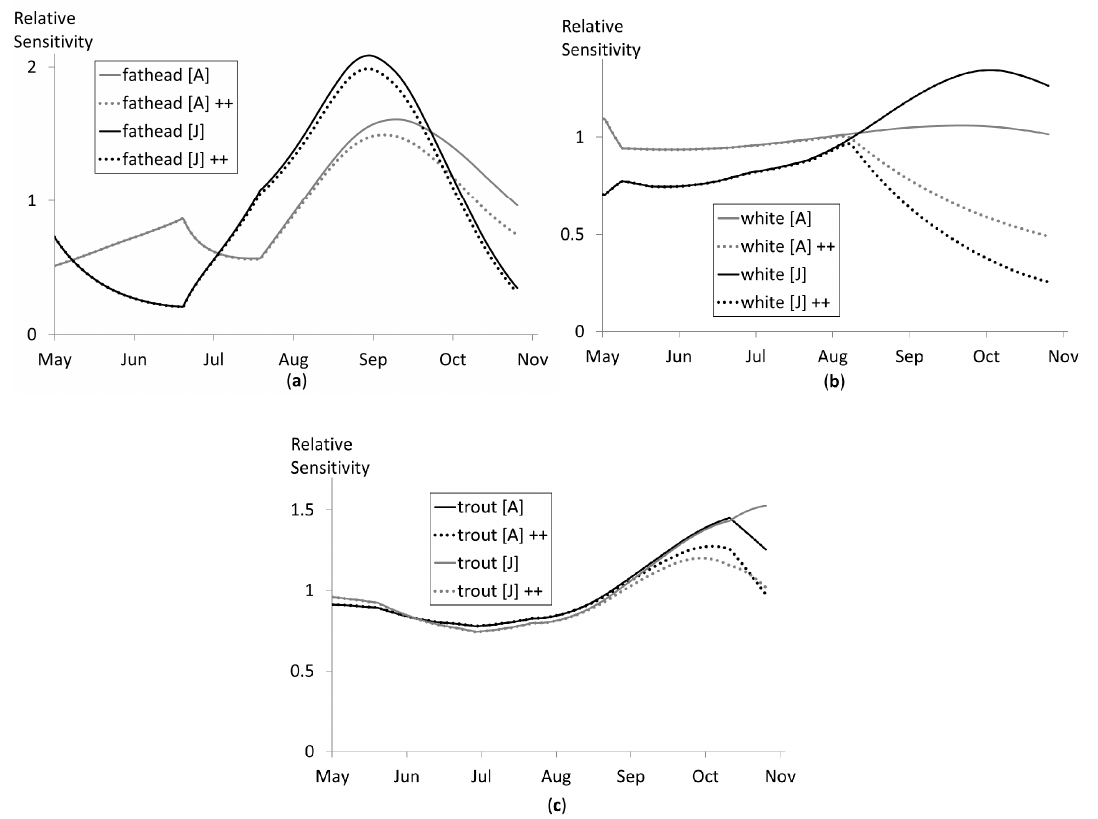
Figure 15. Results of the global sensitivity analysis when increasing ( ++ ) the initial biomass concentration of Chaoborus for ( a ) fathead minnow, ( b ) white sucker and ( c ) lake trout (legend: [A] adults; [J]: juveniles).